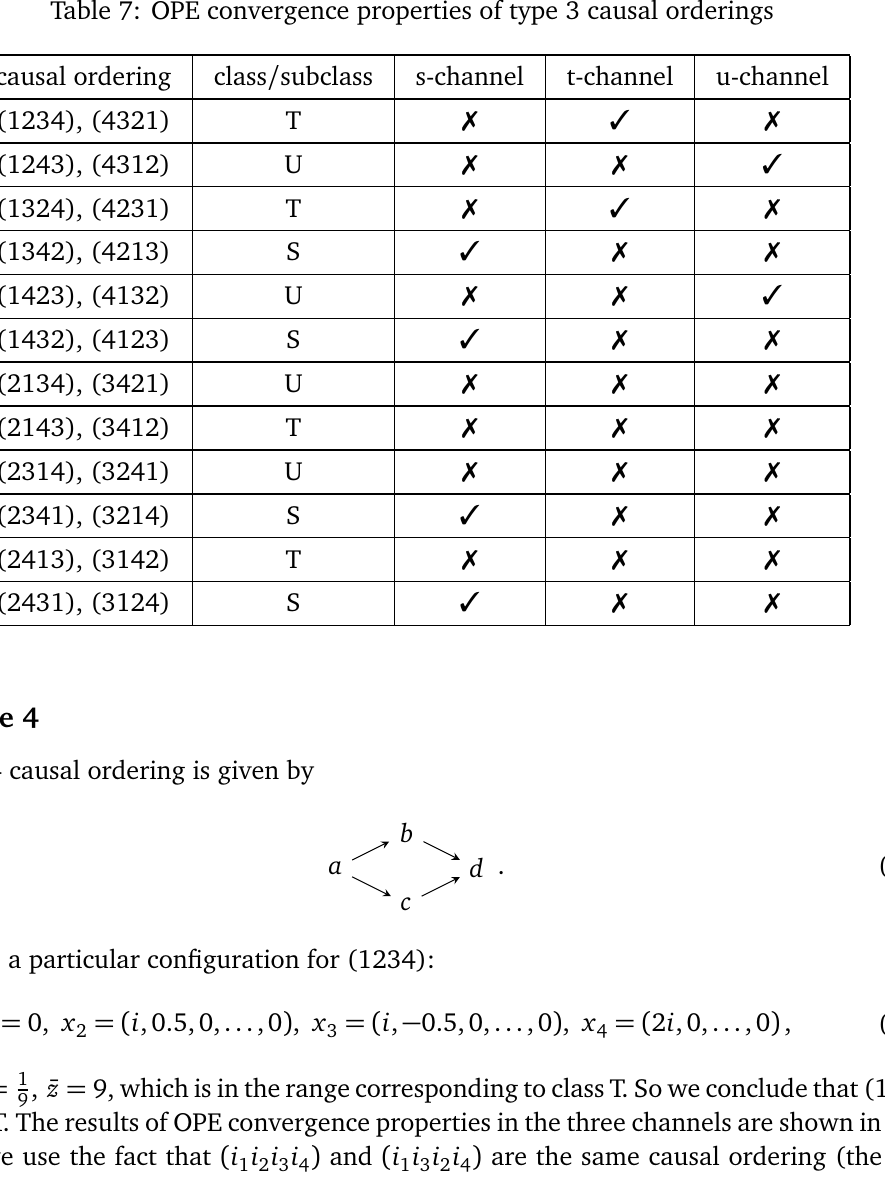
Table 7: OPE convergence properties of type 3 causal